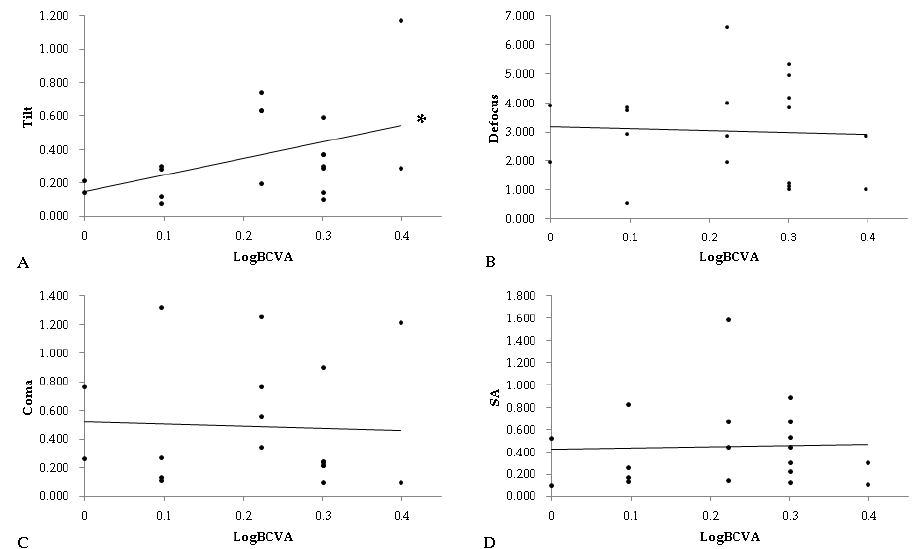
Figure 1. The correlation between best-corrected visual acuity and four types of higher order aber- rations. ( A ): the correlation between BCVA and tilt, ( B ): the correlation between BCVA and defo- cus, ( C ): the correlation between BCVA and coma, ( D ): the correlation between BCVA and